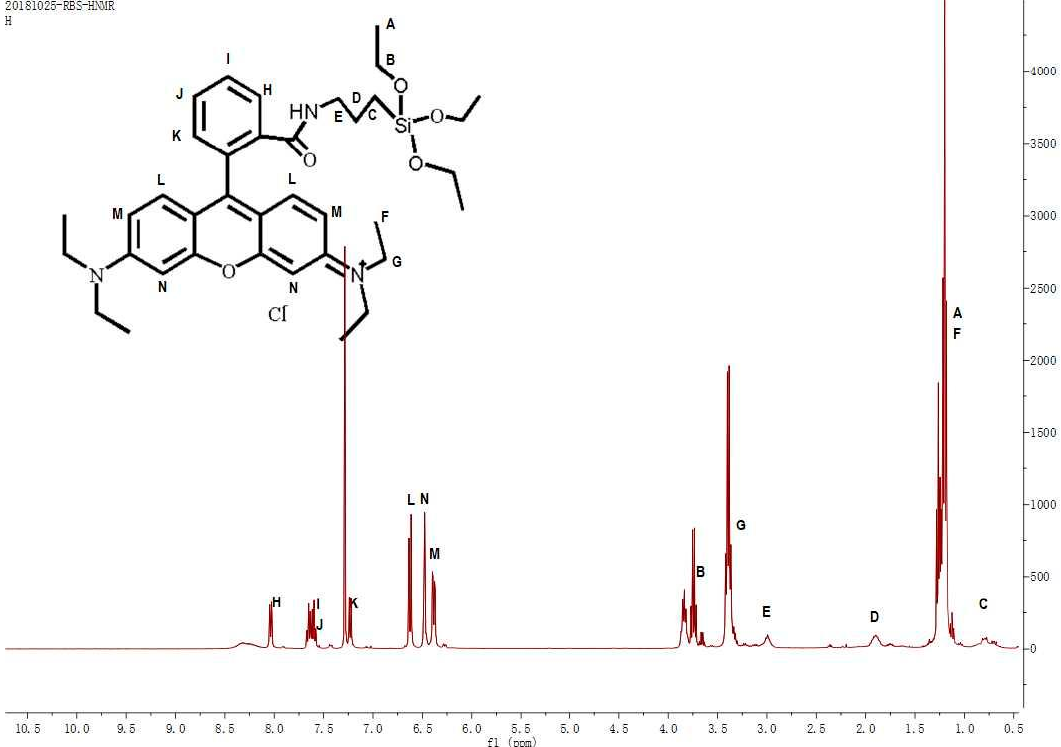
Figure 2. 1 H NMR spectrum of RBS in CDCl 3 .